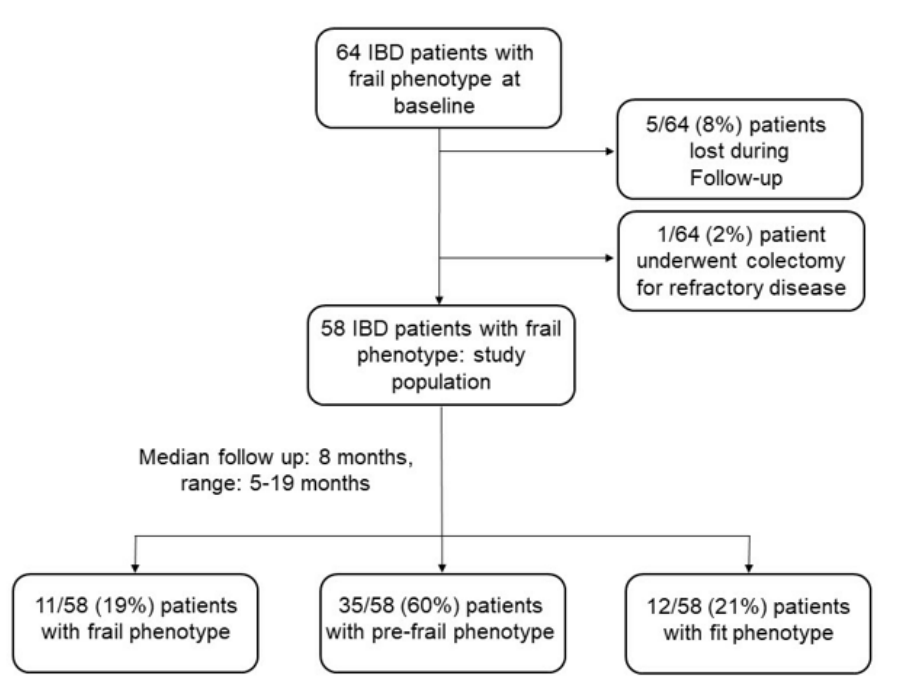
Figure 1. Flowchart of patients with a frail phenotype enrolled in the study. Data regarding the frequency of frail, pre-frail, or fit phenotypes at the end of the study are shown.